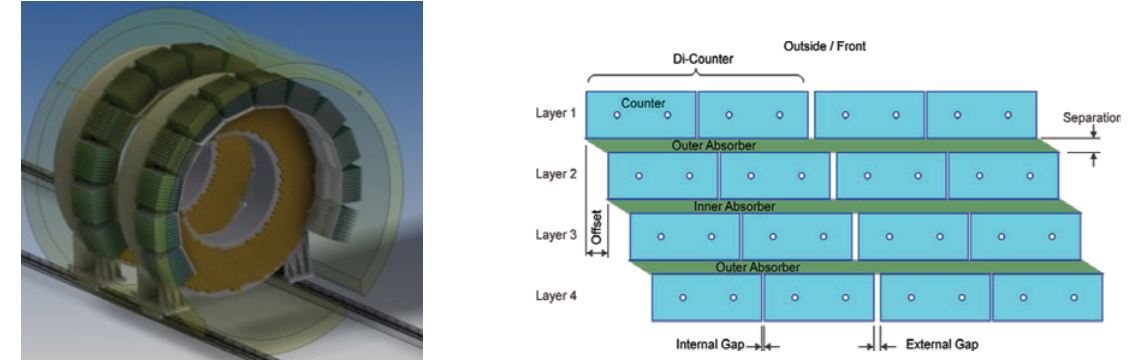
Figure 6. (Left) CAD drawings of the calorimeter disks. Calorimeter innermost (outermost) radius is of 351 mm (670 mm) with a crystal length of 200 mm. Layout of the FEE and digitization crates is also shown. (Right) Schematic drawing of the cross-sectional view of a CRV counter. Each counter is 20 mm thick with a width of 50 or 60 mm and a length up to 6.6